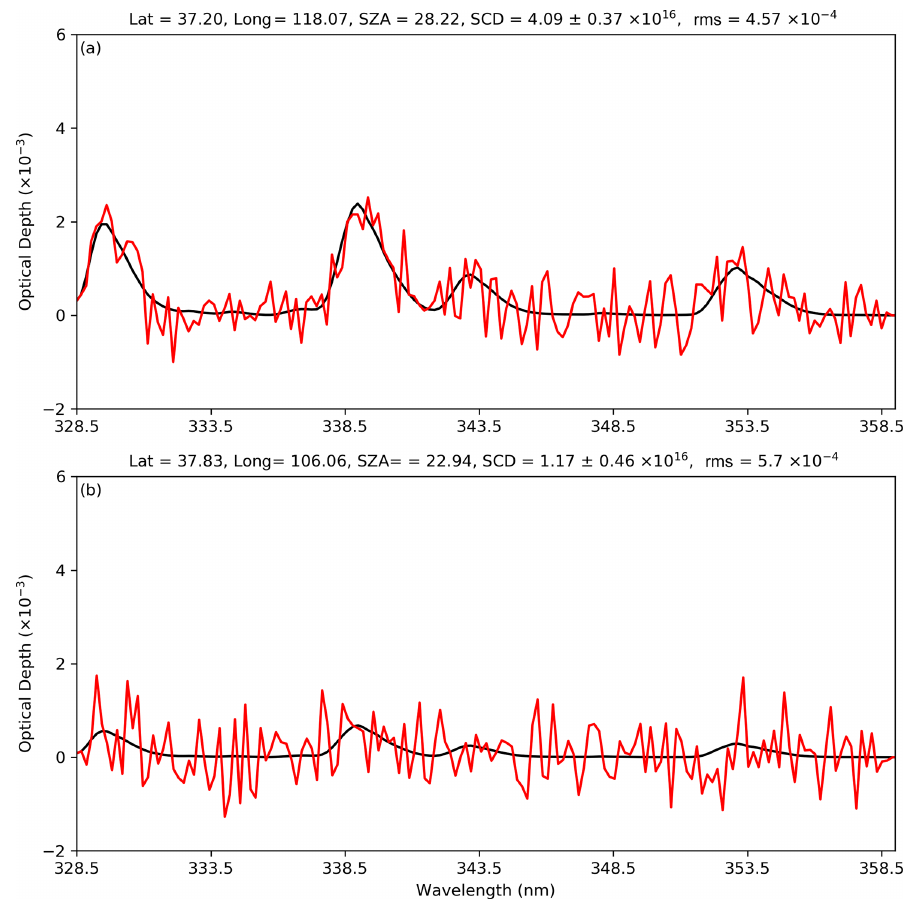
Figure 2. An example of the spectral retrieval of HCHO DSCD from two TROPOMI spectra measured on 6 August 2018 over China (orbit 4211), for (a) a polluted case and (b) a clean case. The black lines represent the simulated HCHO optical depth, and the red lines represent the fitted HCHO optical depth plus fitting